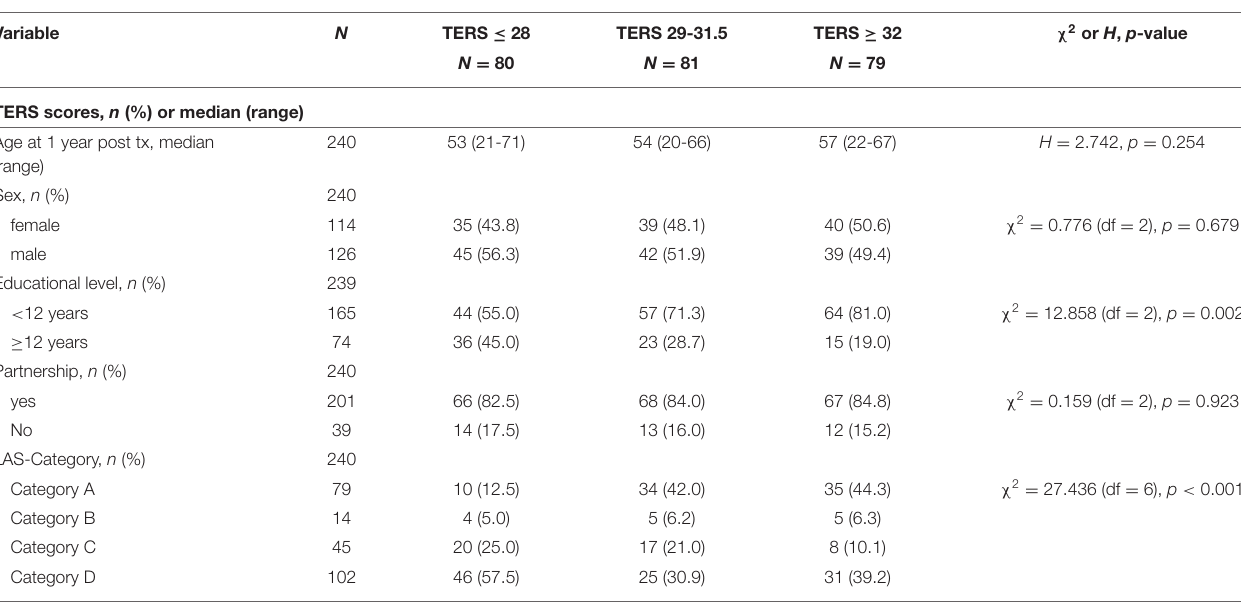
TABLE 2 | Comparison of baseline characteristics divided by TERS